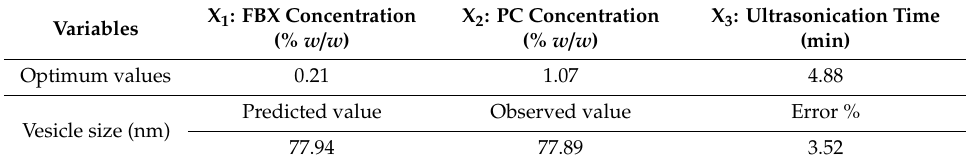
Table4. OptimizedvariablelevelsoftheoptimizedFBX-EMLsanditspredictedandobservedresponses. Table 4. Optimized variable levels of the optimized FBX-EMLs and its predicted and observed